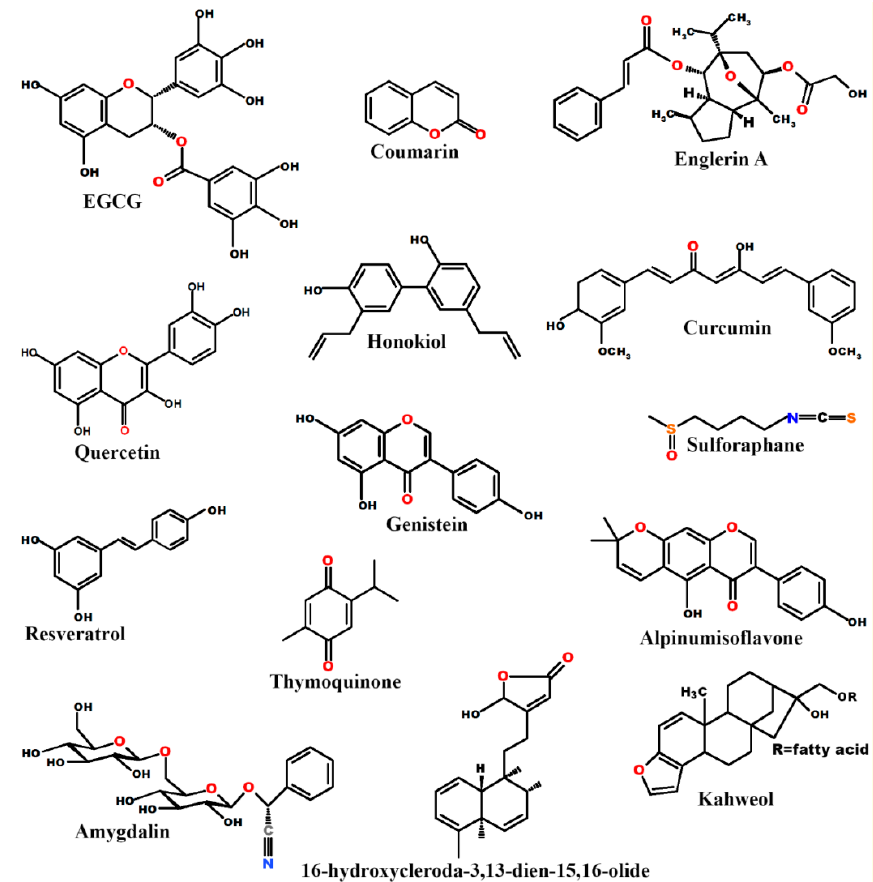
Figure 1. Chemical structures of some commonly studied natural products.